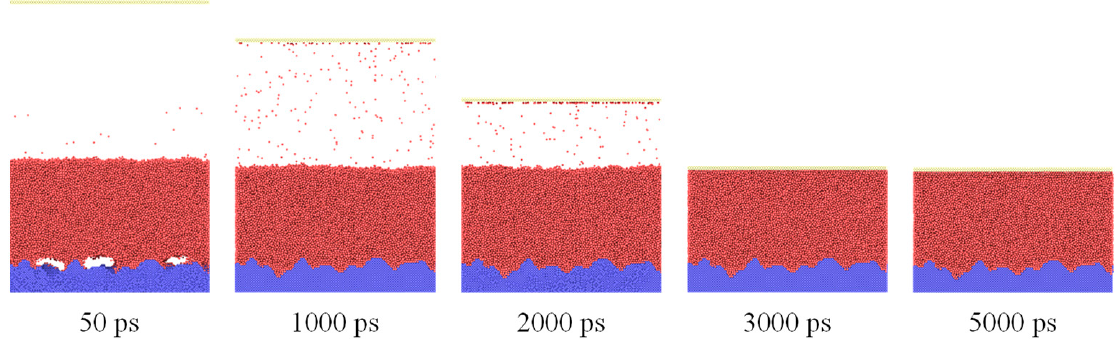
Figure 3. Snapshots of the system at the equilibrium stage.